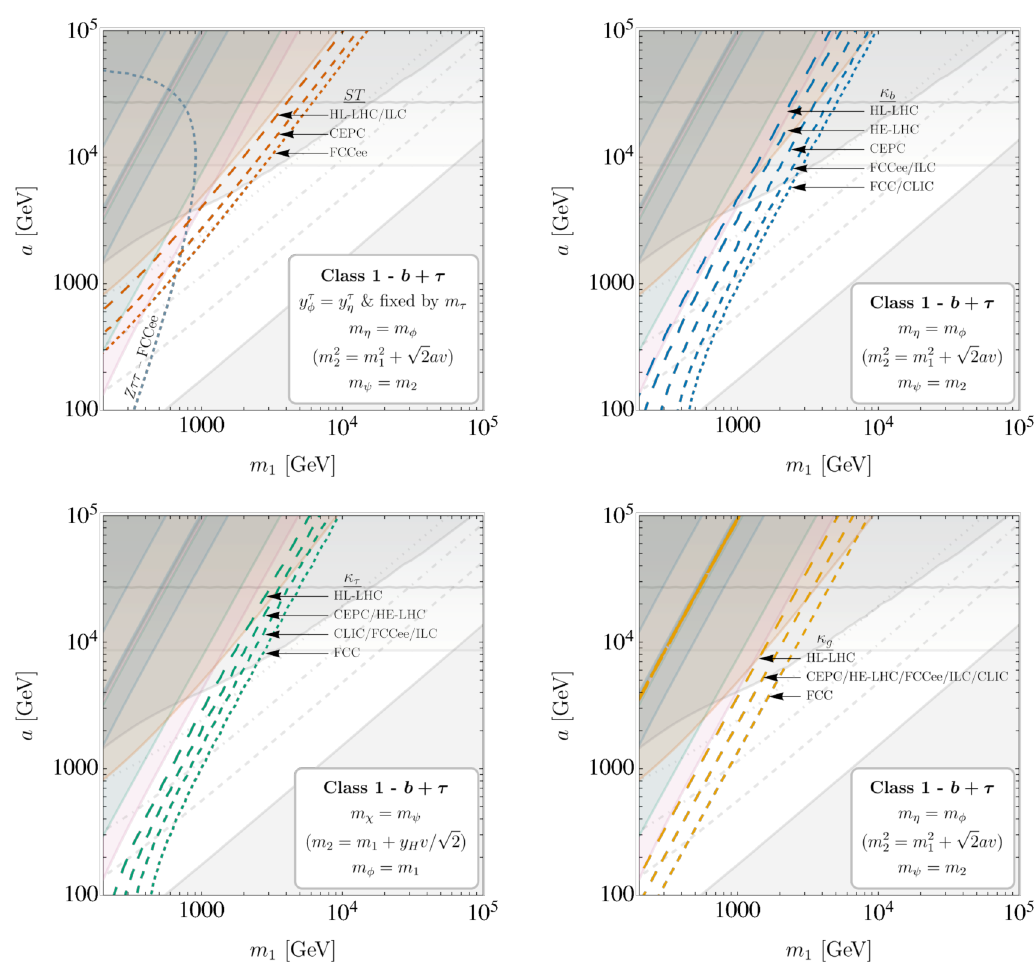
Figure 8. Projected 2 σ experimental sensitivities on the Class 1 combined b + τ benchmark model at future colliders for the left hand slice in fig.